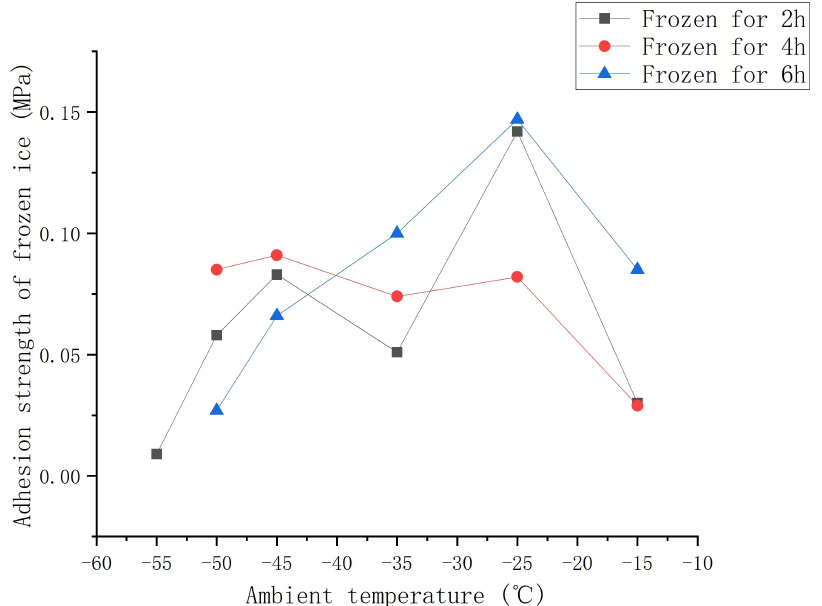
Figure 6. Adhesion strength of frozen ice on the silicone rubber